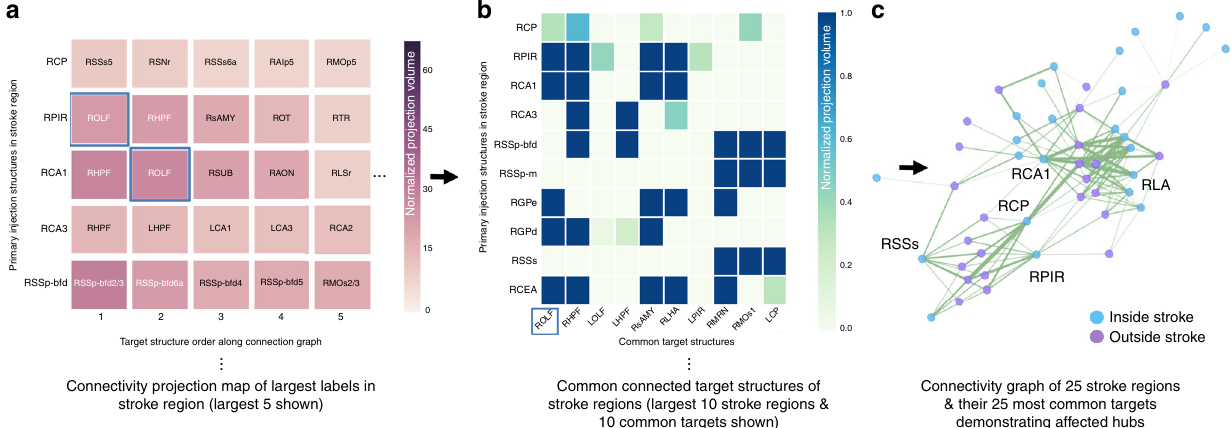
Fig. 5 Examination of the involved networks and connected hubs in the stroke region. a Projection density map of the fi ve largest regions in the stroke incidence mask (dashed line in Fig. 4b) as primary injection sites ( y -axis) and their top fi ve connectivity targets, ranked by connectivity strength ( x -axis). Cell color in both the left and middle panels represents normalized projection volume between the primary injection ( y -axis) and target structure ( x -axis). b Matrix of the largest ten labels, as primary injection sites ( y -axis), in the stroke area and their ten targets most common across all injection sites. c Snapshot of an interactive network graph of the largest 25 labels in the stroke mask and their 25 most common targets, highlighting example hubs (regions with a high degree of connectivity) inside and outside the stroke region. Blue nodes (circles representing brain regions) are regions inside the stroke and purple nodes are outside. Example hubs within the stroke: CP: caudoputamen, PIR: piriform area, SS: somatosensory